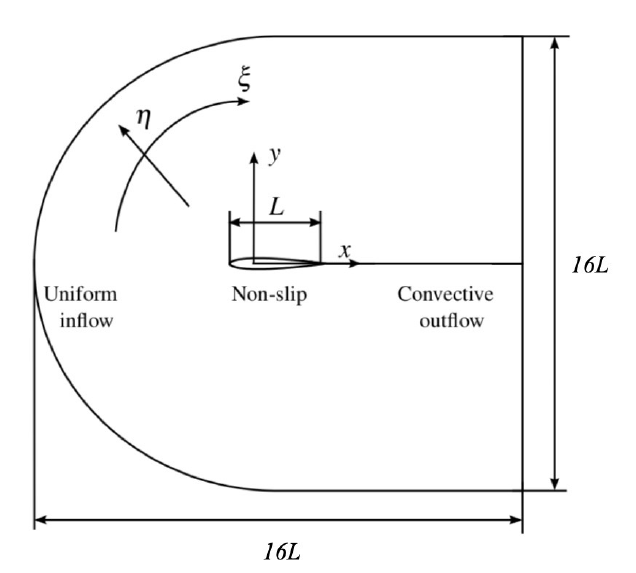
Figure 5. Parameters for the airfoil movements in the case of validation.